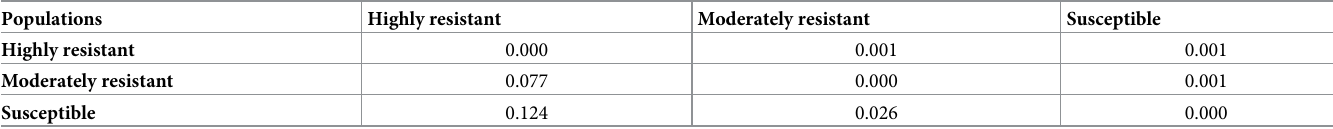
Table 6. Pair–wise F ST estimates among the three populations of rice